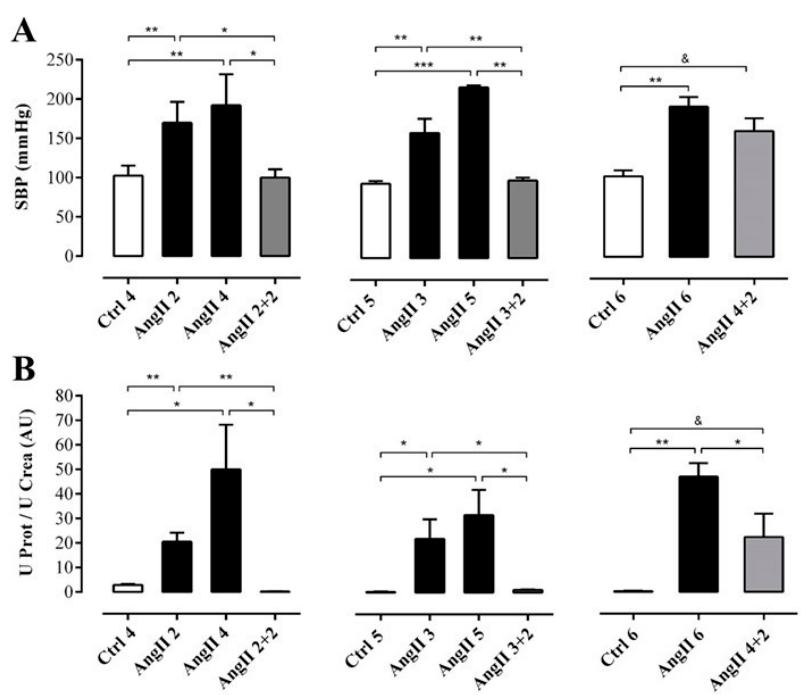
Figure 2. While the SBP remained elevated, the renal function had partly recovered in rats after 2 weeks of withdrawal from 4 weeks treatment with AngII. SBP (mmHg) was measured by plethysmography ( A ). Protein and creatinine were measured in urine samples to assess renal function from ratio UProt / UCrea ( B ). The bars represent the means ± SE of a n ≥ 4 rats per experimental group. The differences between the subgroups in each of the three groups were evaluated by an ANOVA followed by a Tuckey test. *** p < 0.001, ** p <0.01 and * p <0.05 vs. AngII groups; & p < 0.05 vs. AngII 4 + 2.